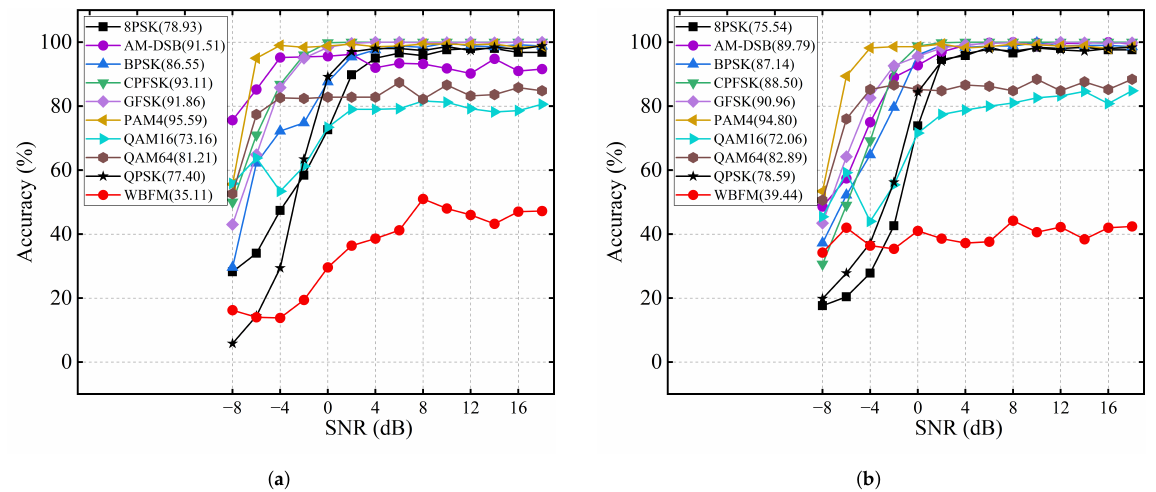
Figure 6. Classification accuracies (%) for ( a ) SE-MSFN and ( b ) LSTM2 at each SNR and modulation type on the 2016A dataset, with the values in parentheses in the legend being the average recognition accuracy for each class across the full SNRs.